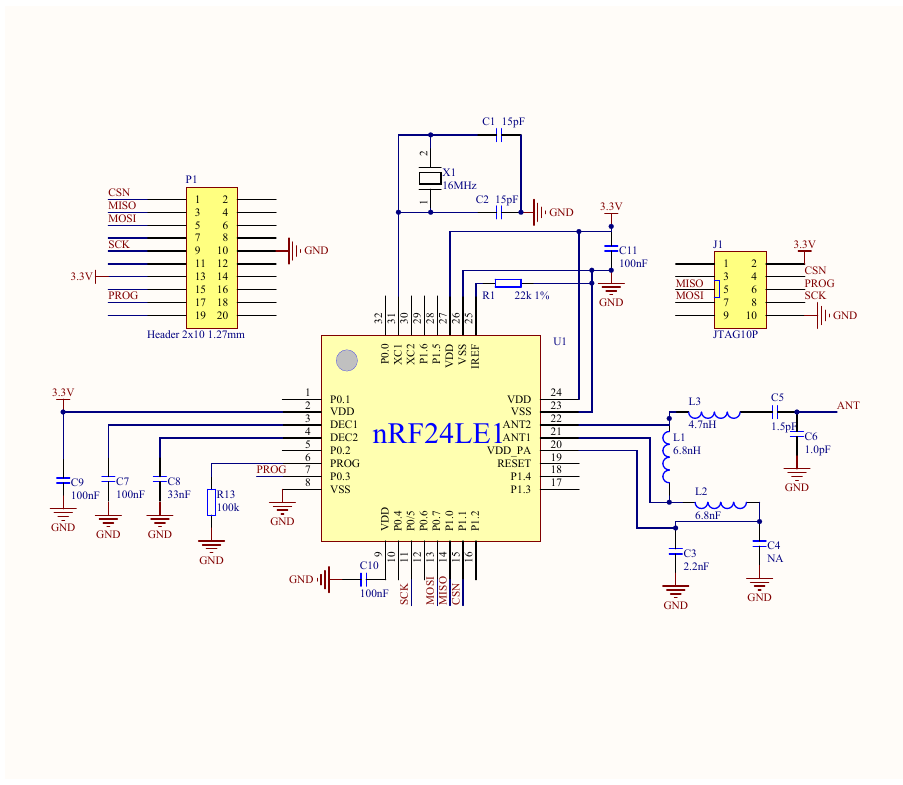
Figure 3. The key circuit diagram of the TrackCC hardware.